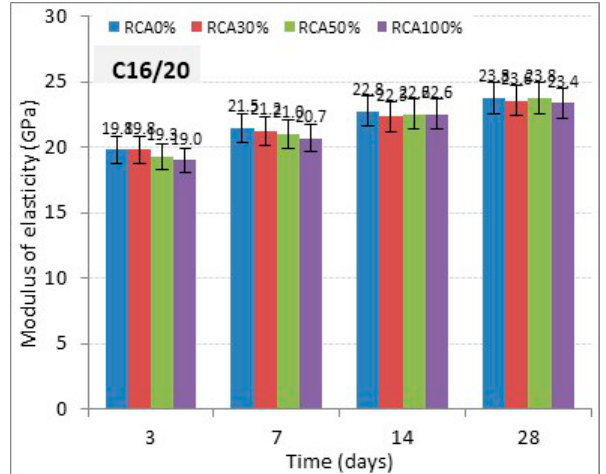
Figure 6. Effect of proportions of RCA on the modulus of elasticity development for C16/20 Figure 6. E ff ect of proportions of RCA on the modulus of elasticity development for C16 / 20 concretes.